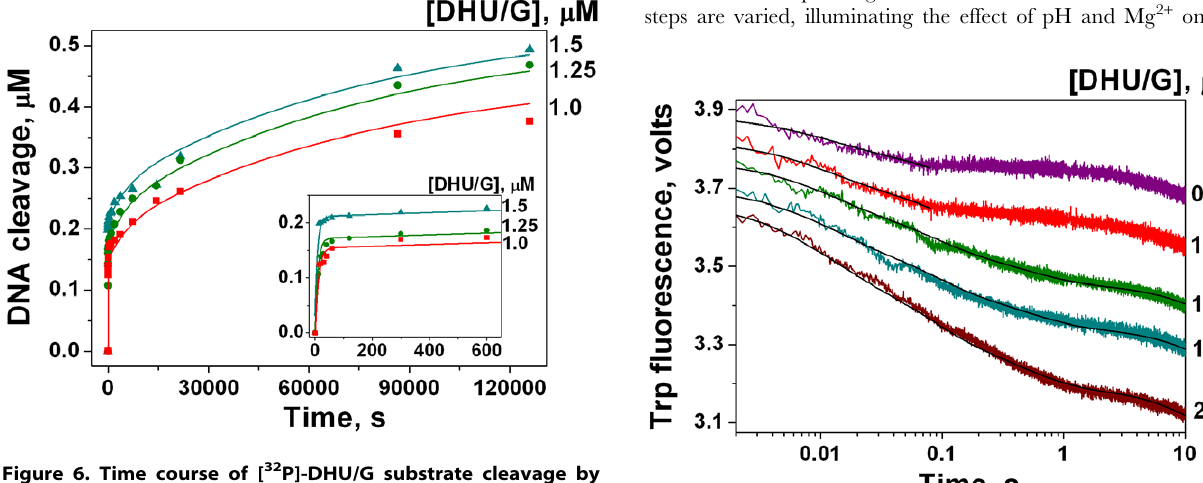
Figure 6. Time course of [ 32 P]-DHU/G substrate cleavage by APE1K98A (1 m M). The reaction was carried out in NIR buffer. Concentrations of the substrate are indicated next to the right axis. The initial region of the kinetic curves is shown on the insert that corresponds to the phase 1 observed in the time range , 100 s. Phase 2 is observed in the time range 100 , t , 20000 s. Phase 3 corresponds to the slow accumulation of cleaved DNA at t . 20000 s. doi:10.1371/journal.pone.0024063.g006 PLoS ONE |